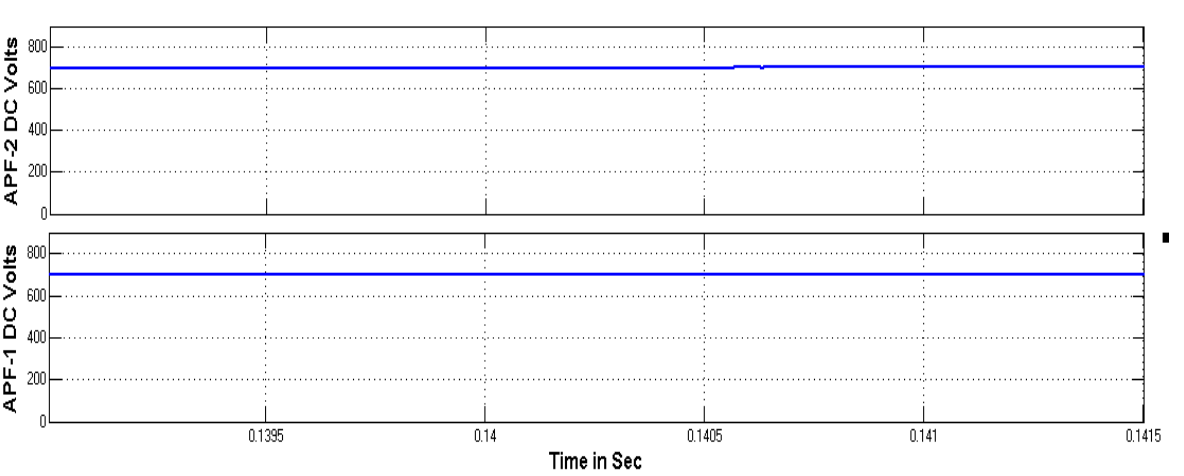
Figure 31. Load current and voltage phase angle